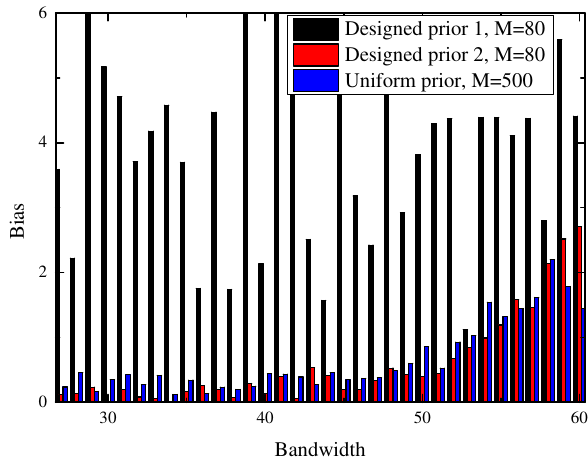
Figure 2. Bias of bandwidth detection under different priors.